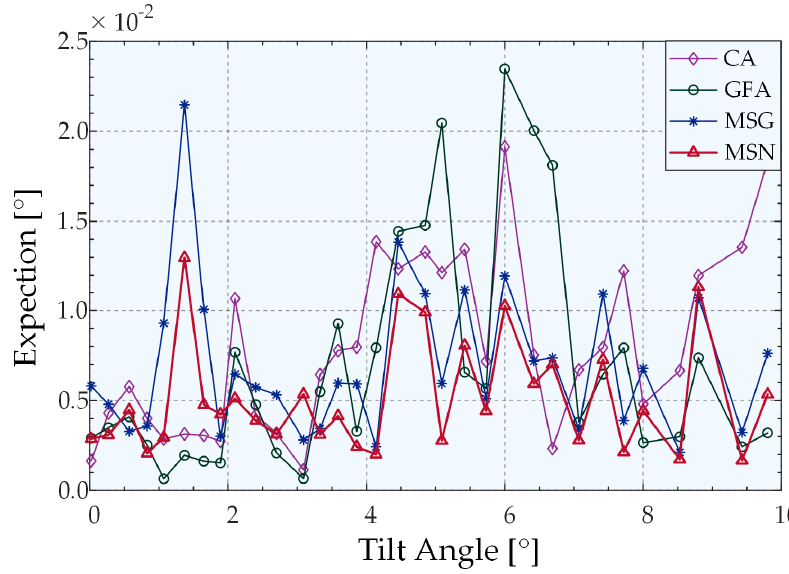
Figure 17. Algorithmic extraction performance with large energy fluctuations.